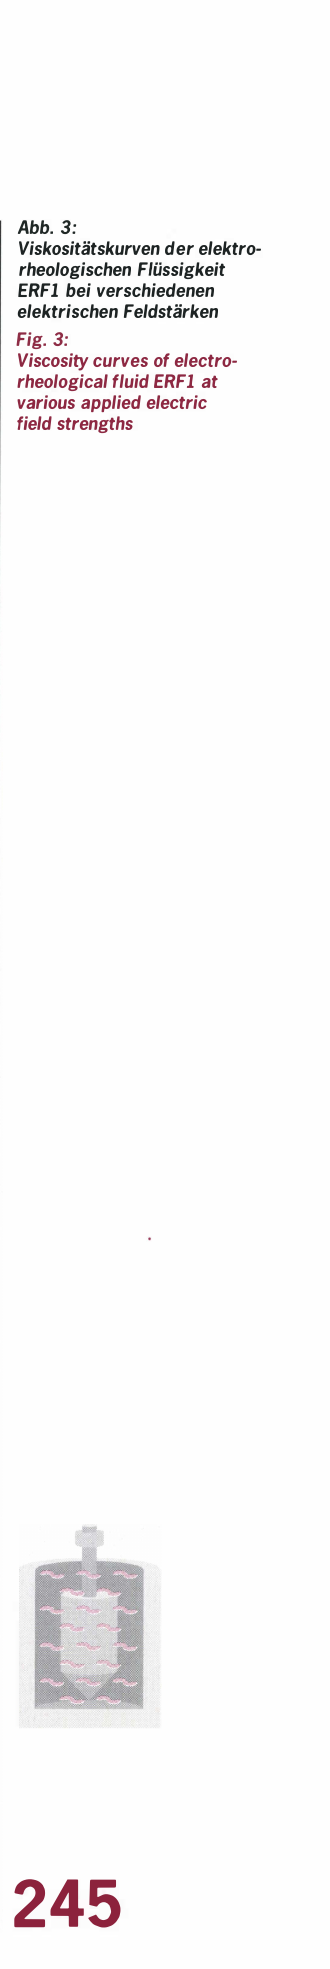
Fig. 2: Flow curves of the ERFs tested at various electrical currents (field strengths)